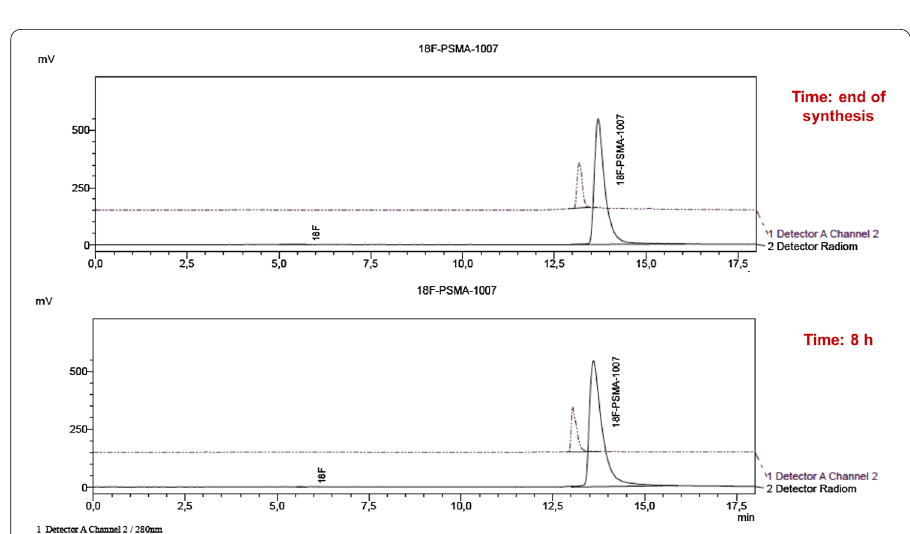
Fig. 1 Radio-HPLC chromatograms performed at the EOS and after 8 h. The UV signal (Detector A Channel 2, 220 nm) of the PSMA-1007 and the radiometric of [ 18 F]PSMA-1007 (Detector Radiom) due to the radiolabeled compound overlapped. The stability of radiolabeled peptide is confirmed up to 8 h after